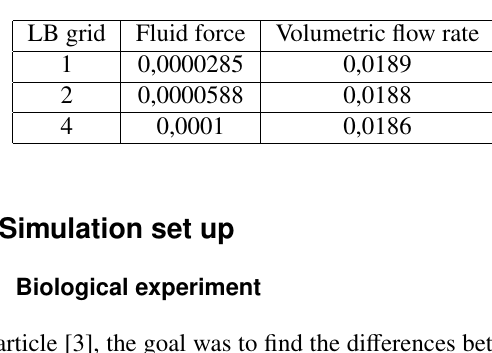
Table 3. Testing relationship between LBgrid and fluid force